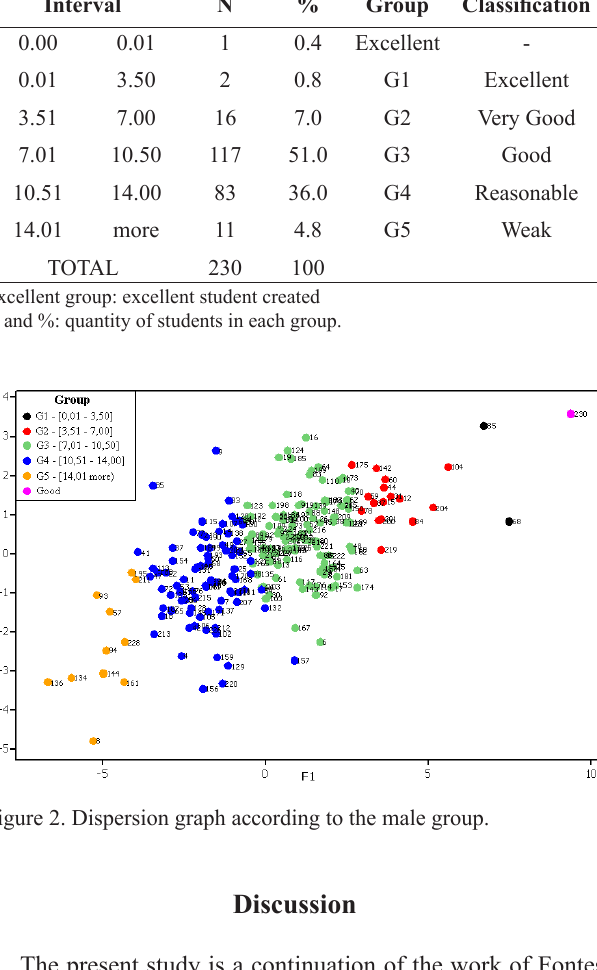
Table 4. Result of correspondence factors of each physical test stipu- lated by PROESP-BR of males.